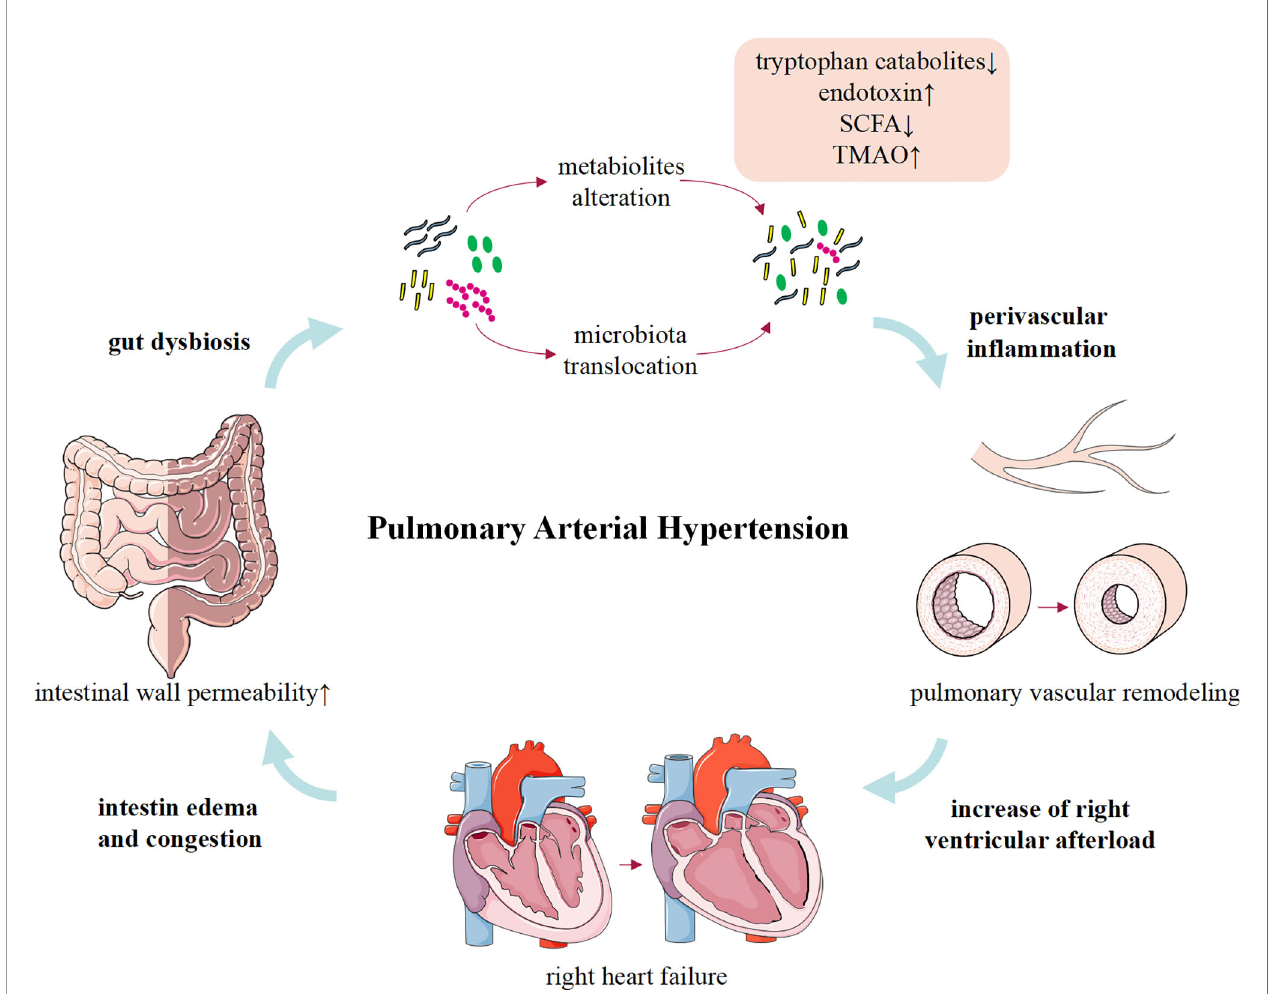
FIGURE 1 | The role and potential mechanism of gut dysbiosis in pulmonary arterial